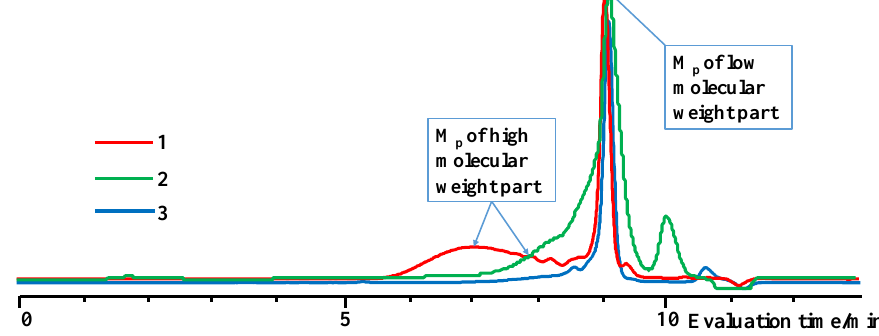
Figure 3. GPC curves of products 1, 2, 7 (Table 1). Further interactions were carried out by adding a solution of dichlorodiorganosilane to a solution or suspension of the salt in THF or MTBE, respectively.